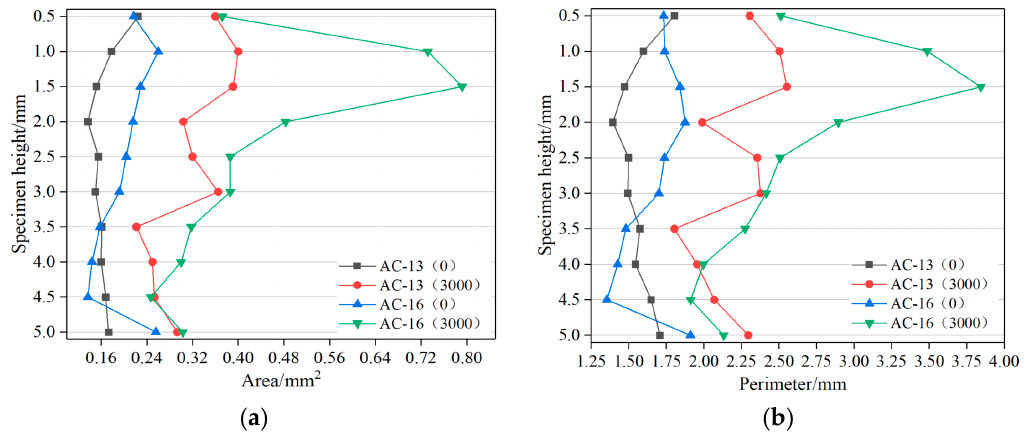
Figure 17. Variation of the average area and perimeter of air voids along specimen height ( a ) Average area; ( b ) Average perimeter.